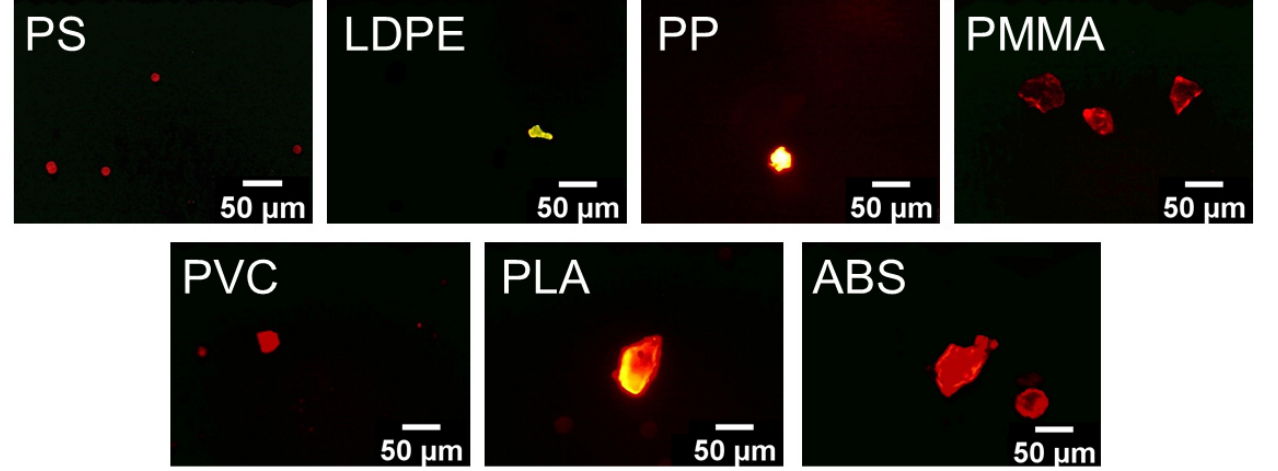
Figure 4. Microscopic images of Nile Red (NR) stained MPs. The particles were illuminated under a blue excitation range of 450–480 nm and an emission filter at 515 nm. Three concentrations (i.e., low: 400 particle mL − 1 , medium: 4000 particle mL − 1 , high: